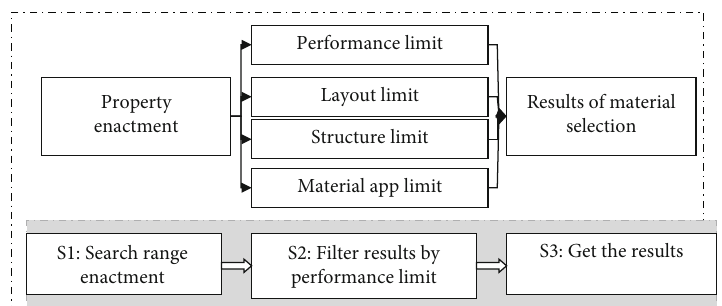
Figure 3: Methods of material selection: fi lter.